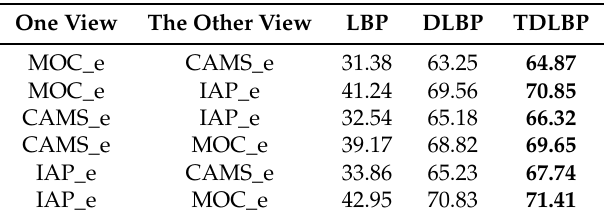
Table 3. Multi-view cloud recognition accuracies (%) using different features.